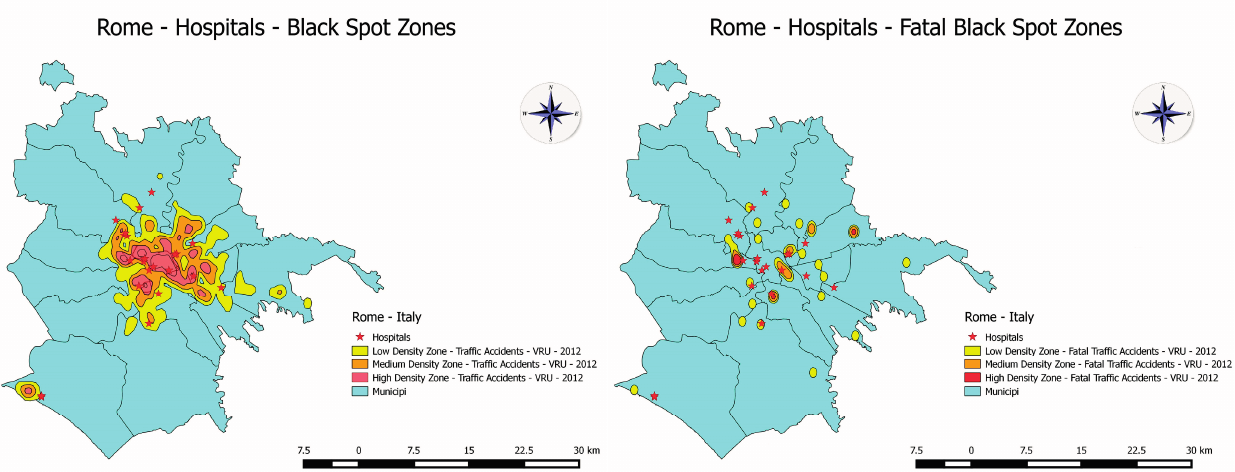
Figure 12. Hospitals/black spot: Rome.